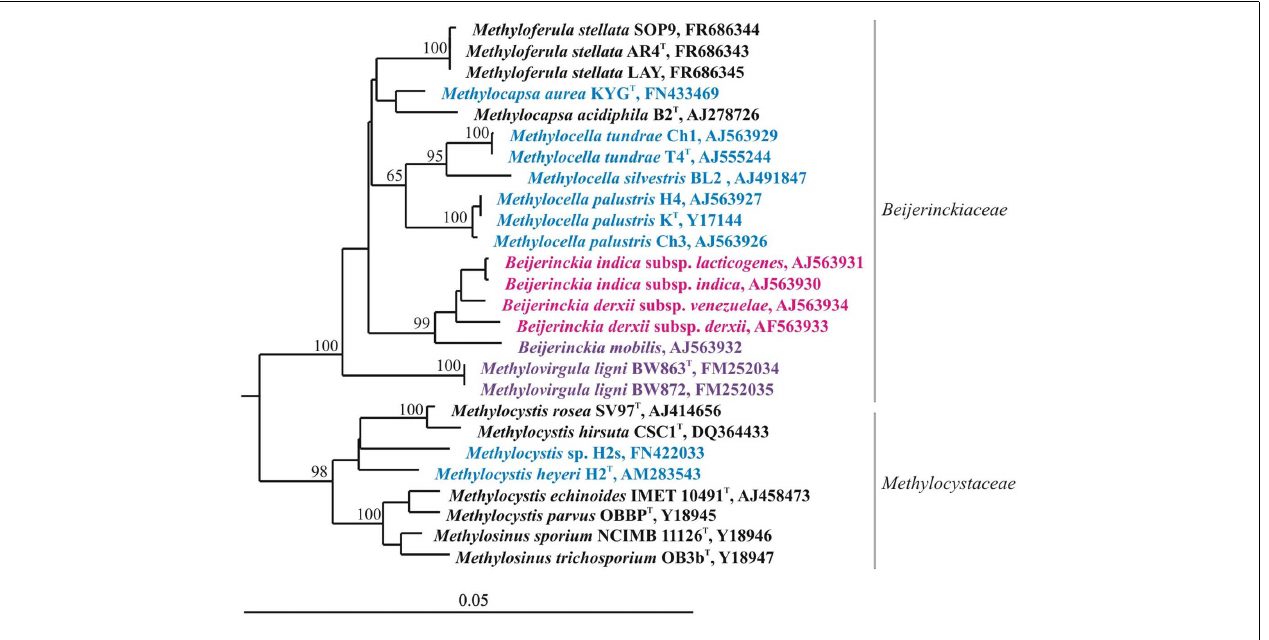
methanotrophs, violet indicates facultative methylotrophs, while pink indicates chemo-heterotrophs. Bootstrap values (1000 data resamplings) > 60% are shown. Bar, 0.05 substitutions per nucleotide